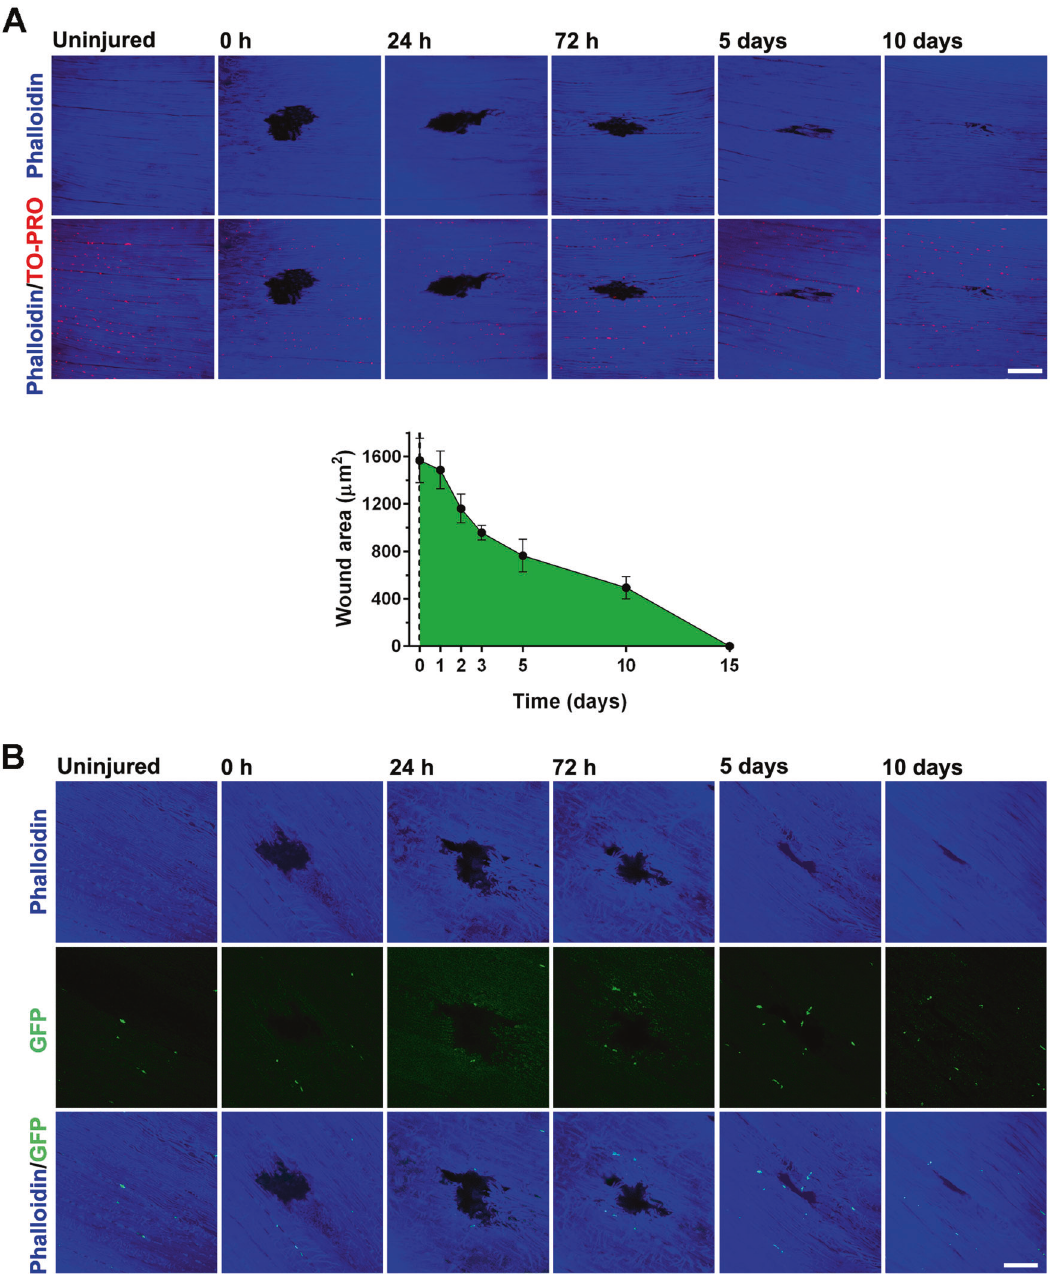
Fig. 4 Acute skeletal muscle injury in D. melanogaster . A Confocal fl uorescence imaging of Phalloidin (blue) and TO-PRO (red) in DLM longitudinal sections of Oregon wild-type fl y strain before (uninjured) and after physical damage at increasing times. Low panel: time-course measurement of the wound area. B Confocal fl uorescence imaging of Phalloidin (blue) and GFP (green) in DLM longitudinal sections of Zfh1>GFP fl ies before (uninjured) and after physical damage at increasing times. Scale bars: 20 µm. Images and quantitative data are representative of 30 ≤ n ≤ 60 fl